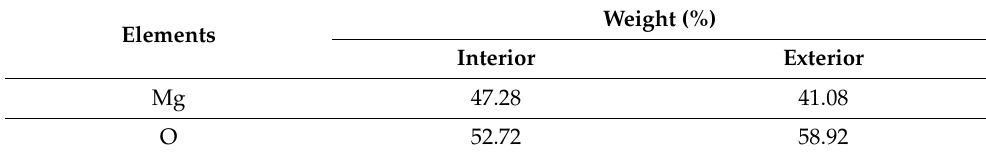
Figure 18. XRD diffraction pattern of magnesium combustion’s by-products. Indexed according to JCPDS cards: 00-035-0821 (magnesium), 01-084-2164 (magnesium hydroxide), 01-071-2640 (magnesium nitride), and 00-004-0829 (magnesium oxide).